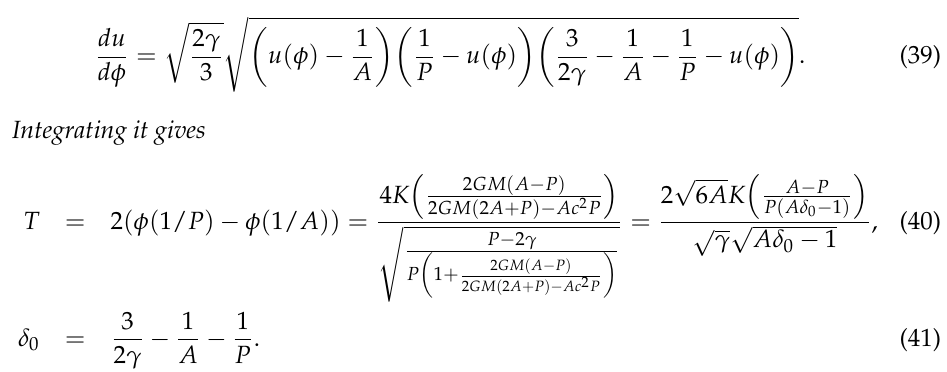
Figure 1. Advance of Mercury’s perihelion.